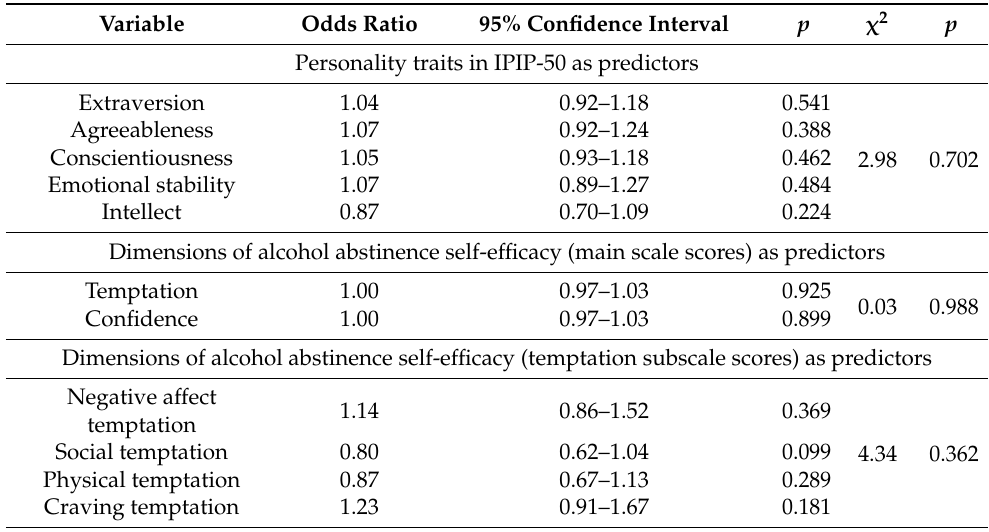
Table 1. Personality traits, dimensions of self-esteem, and depressive symptoms as predictors of abstinence in the investigated